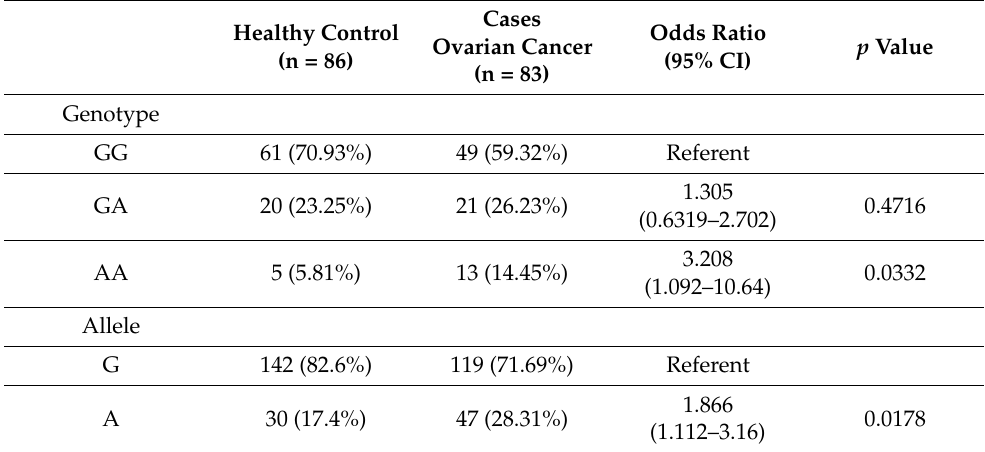
FIGO: International Federation of Gynecology and Obstetrics staging TNM: Tumor, Lymph Node and Metastasis grade * indicates p < 0.05, is considered statistically significant as compared to FIGO Stage I, II and TNM grade 1,2. Table 3. Frequency distribution of the Lysyl Oxidase gene G473A polymorphism in healthy control as compared ovarian cancer patients